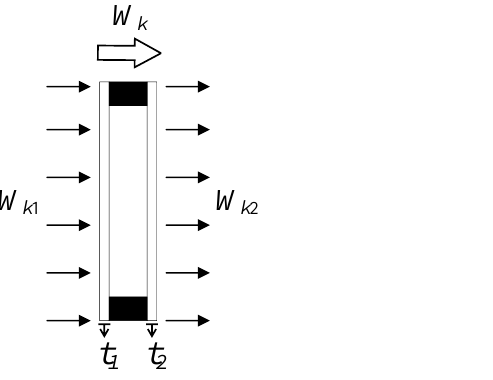
Figure 4. Wind load distribution of the hollow double-layer glass panel. The pressure measurements of the target high-rise building were conducted in a boundary wind tunnel, as shown in Figure 5. Since there are few surrounding buildings around the target high-rise building in most wind directions, the power law exponent of the mean wind speed profile is determined to 0.15 conservatively. The scale ratio is 1:320 and the wind directions range from 0° to 360°, with an interval of 15°. µ sl of each pressure tap at each wind direction were obtained. The µ sl at the height of 7.5 m of each glass panel at typical wind directions are shown in Table 2. It is worth noting that, since there are interference effects of surrounding buildings, as shown in Figure 5, the µ sl of the glass panels #1–3 are negative, which means that the wind loads are suctioning and much different from those on an isolated building.